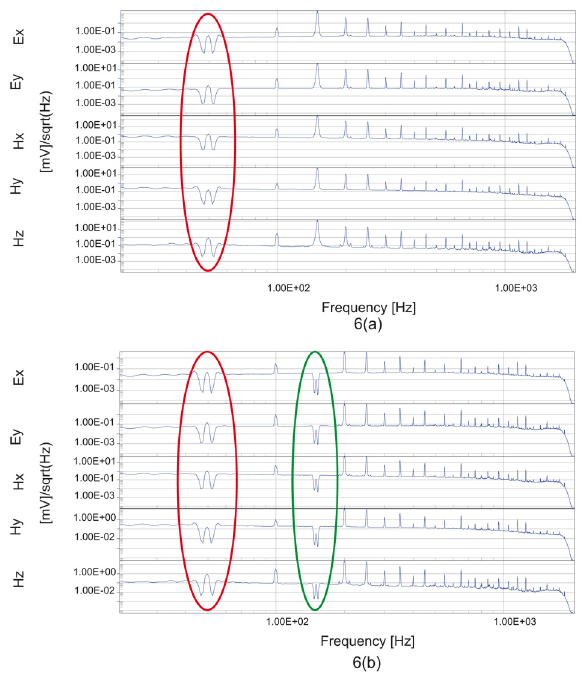
Figure 6. Stacked spectra of 4 KHz data set after notch filtering. (a) Stacked spectra showing the effect of FIR notch filtering on 50 Hz frequency which is indicated by red mark. (b) Stacked spectra show- ing the effect of FIR notch filtering on 50 Hz and its harmonic 150 Hz frequencies which are shown by red and green mark respectively.